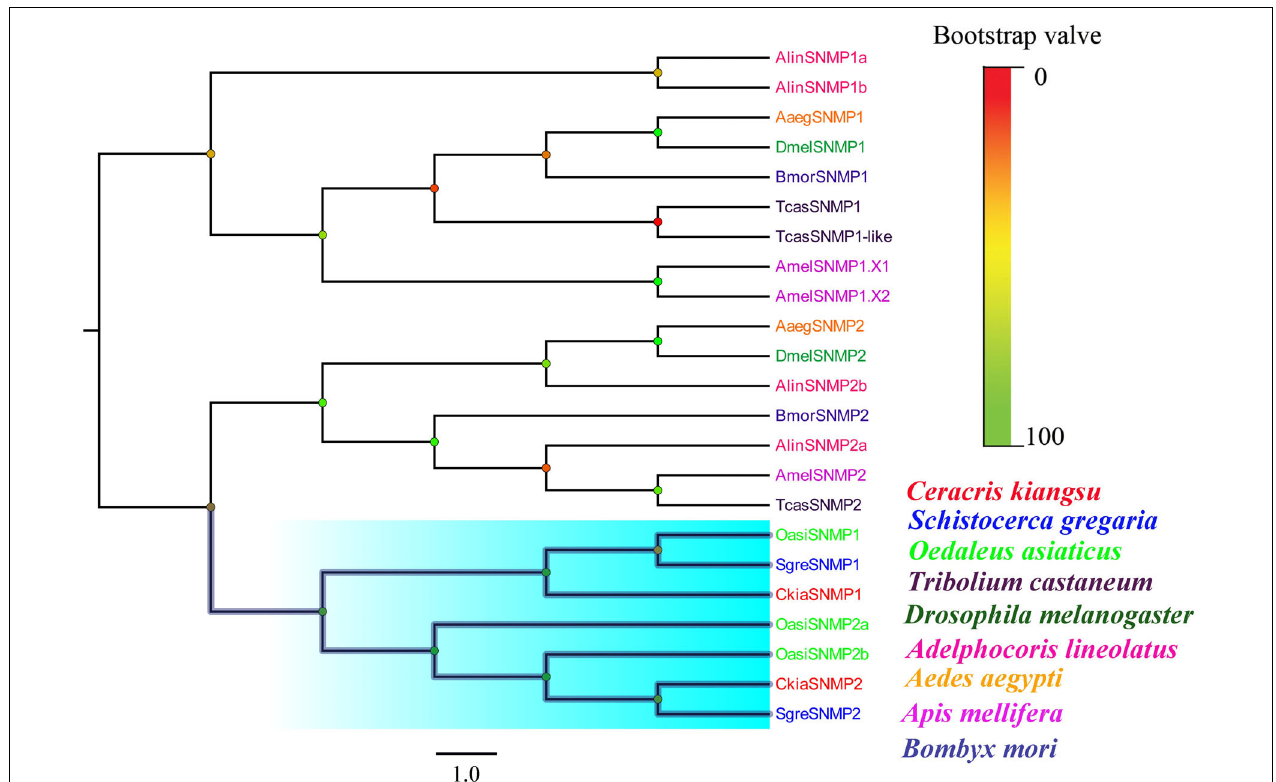
FIGURE 6 | Phylogenetic tree of putative sensory neuron membrane proteins (SNMPs) from C. kiangsu and other insects. Branch support was estimated using bootstrap values based on the scale indicated on the top